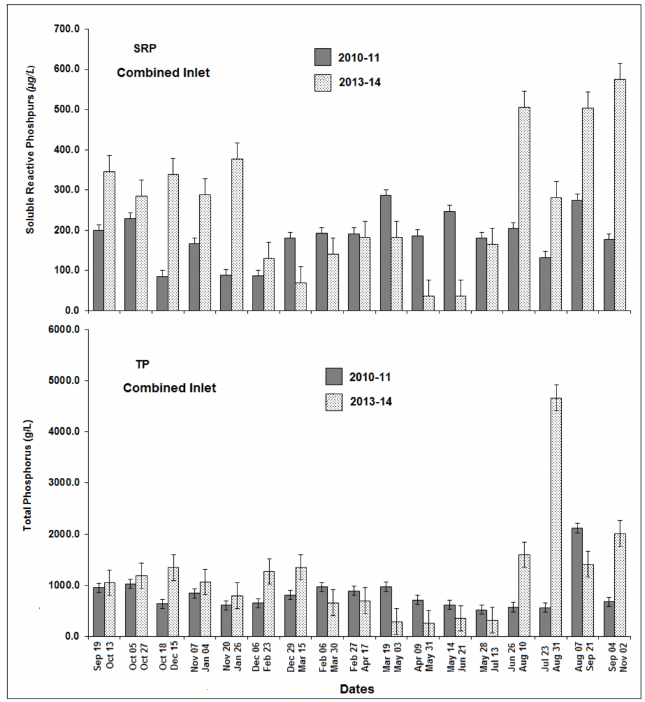
Figure 8. Soluble reactive phosphorus (SRP) and total phosphorus (TP) concentrations ( µ g/L) measured at the combined inlet from 19 August 2010 to 4 September 2011 and from 13 October 2013 to 2 November